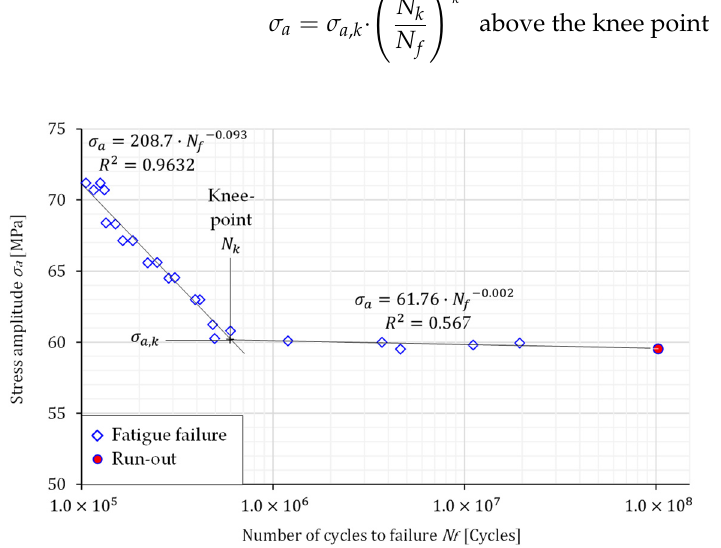
Figure 6. The S–N curve for the rolling direction.